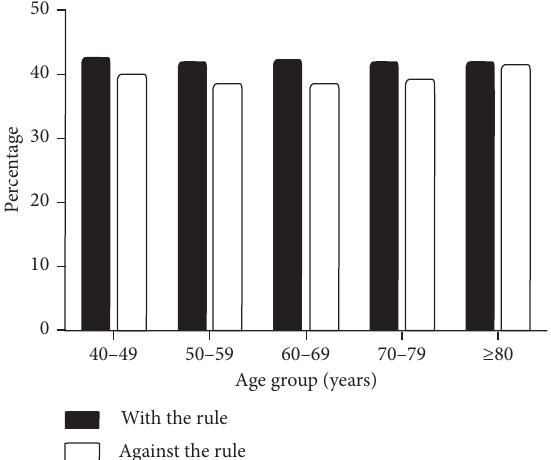
Figure 2: Proportion of WTR and ATR astigmatism in each age